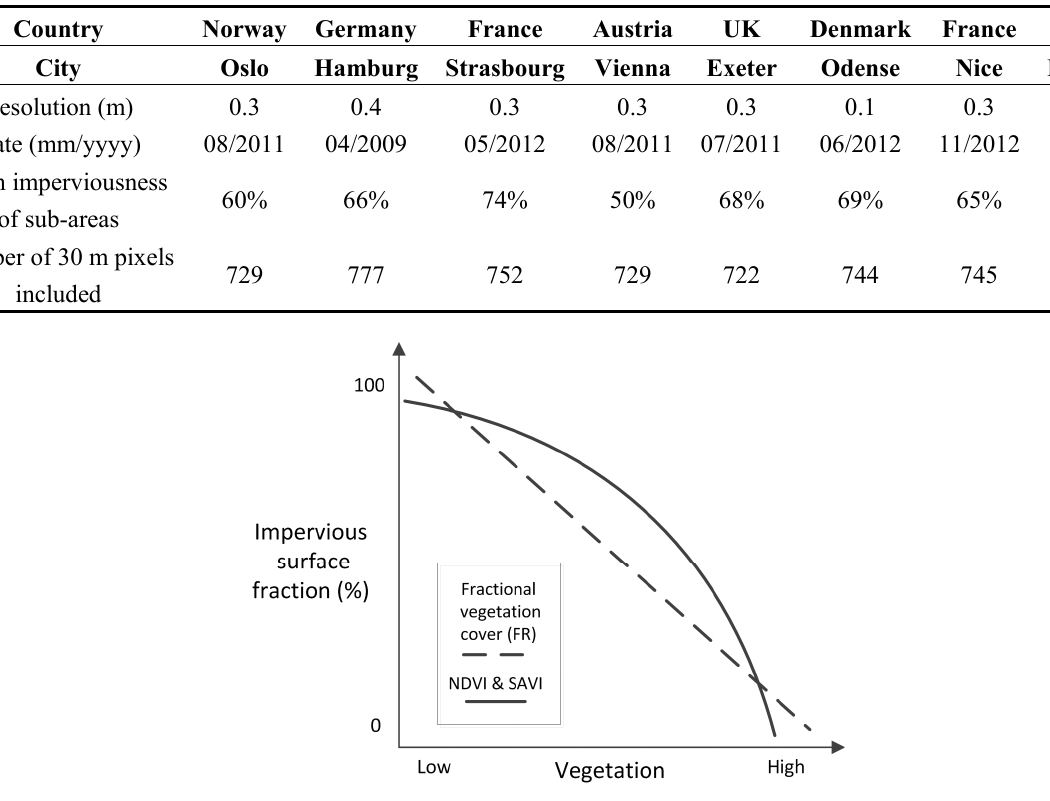
Figure 2. Conceptual relationship between vegetation indices from Landsat imagery and sub-pixel imperviousness (adapted from